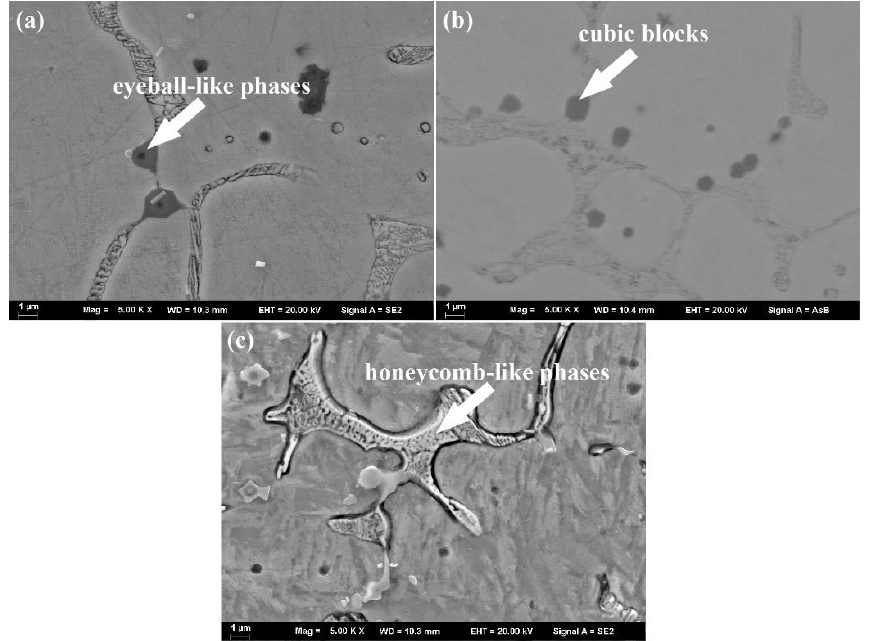
Figure 8. Enlarged views of red rectangles: ( a ) area B in Figure 7a; ( b ) area C in Figure 7a; ( c ) area D in Figure 7b.